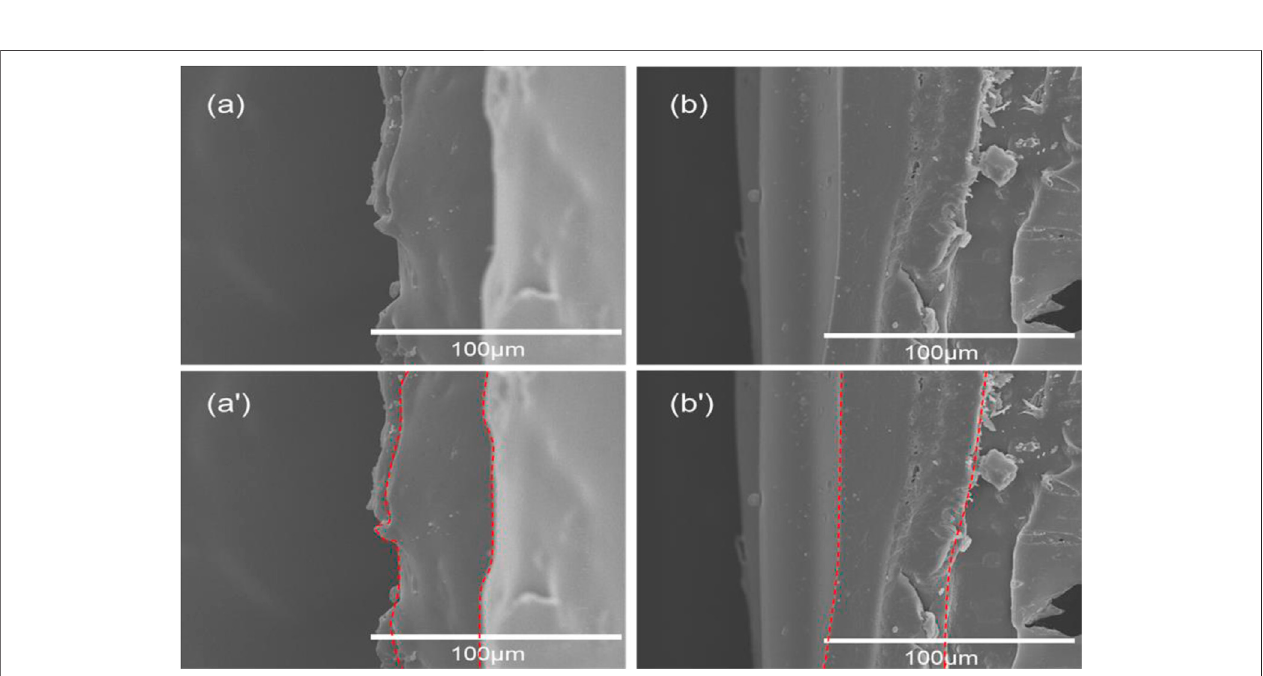
FIGURE 2 | Cross-sectional SEM images of composite scaffolds with different amounts of PDTEC coating: (A, A 9 ) TMBG-PDTEC8 and (B, B 9 ) TMBG-PDTEC16 scaffolds.